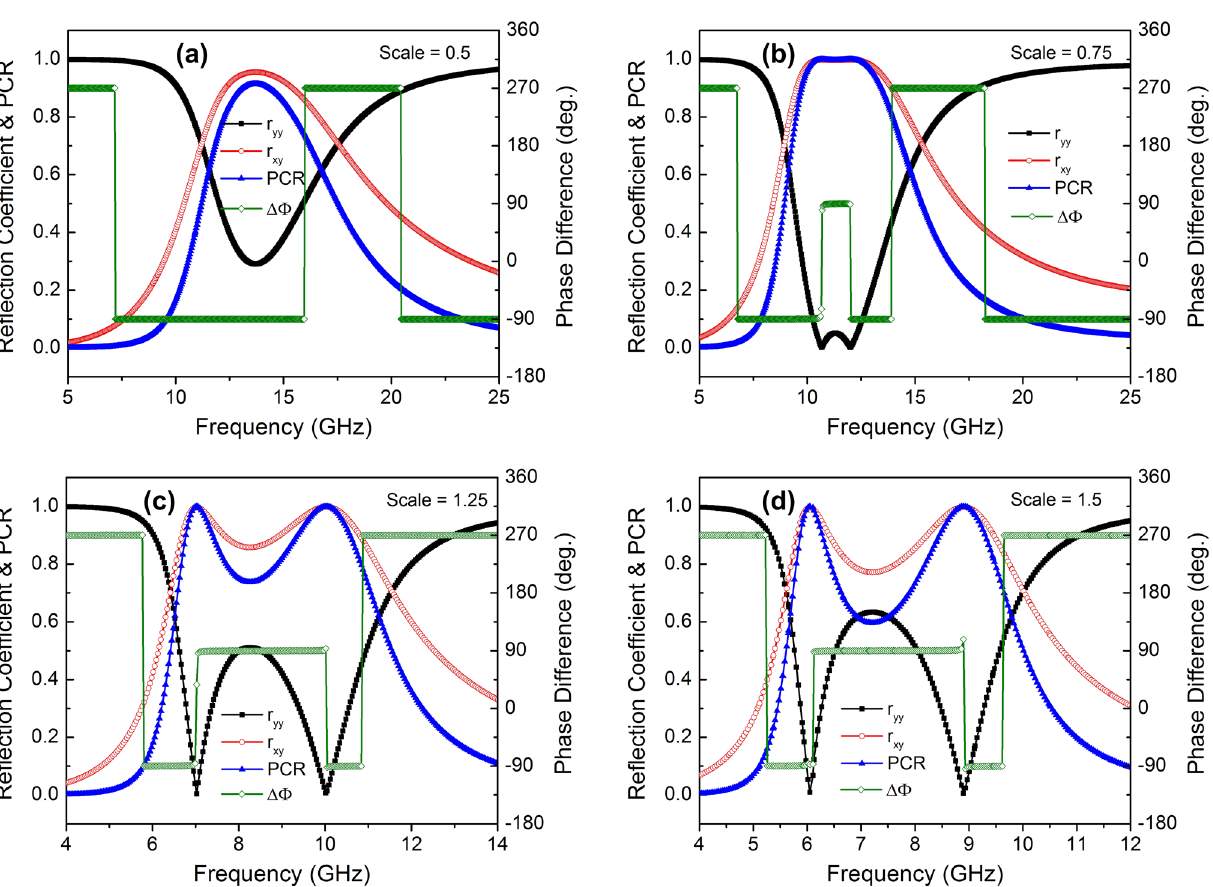
Figure 10. Magnitude of co- and cross-polarized reflection coefficients, phase difference, and PCR of the proposed polarization converter for different scaled physical dimensions in xy-plane: ( a ) 0.5, ( b ) 0.75, ( c ) 1.25, and ( d )